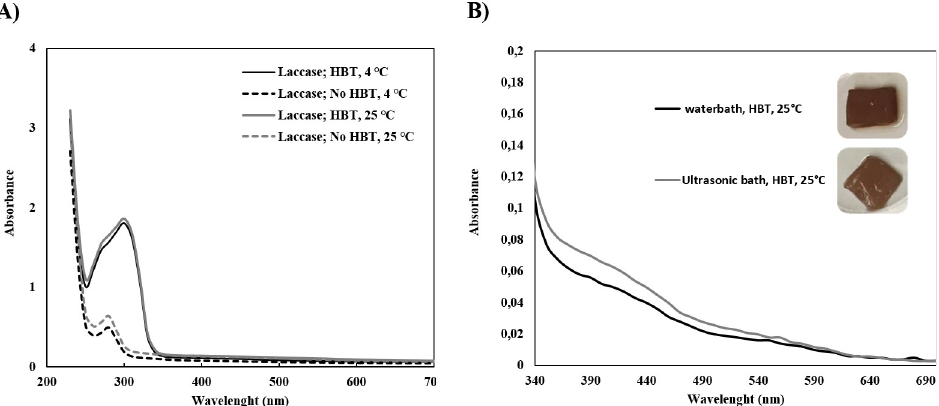
Fig 1. UV-Visible spectra of polyaniline solutions in presence of HBT after polymerization with laccase: A) spectra of polyaniline solutions at 4˚C and 25˚C, with and without mediator at wavelength between 230–650 nm, using a water bath as reactor; B) spectra of polyaniline between 340–690 nm after polymerization using both water bath (a) and ultrasonic bath (b)